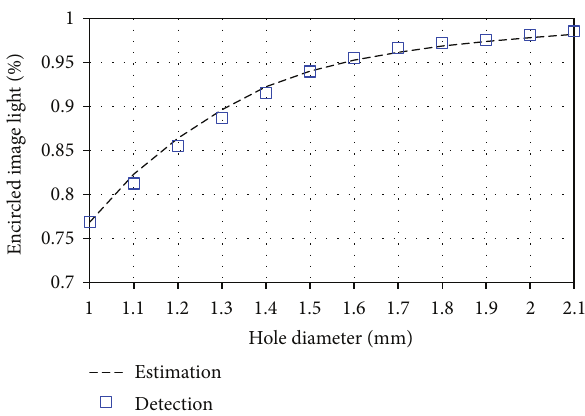
Figure 15: Measurement and calculation of the encircled image